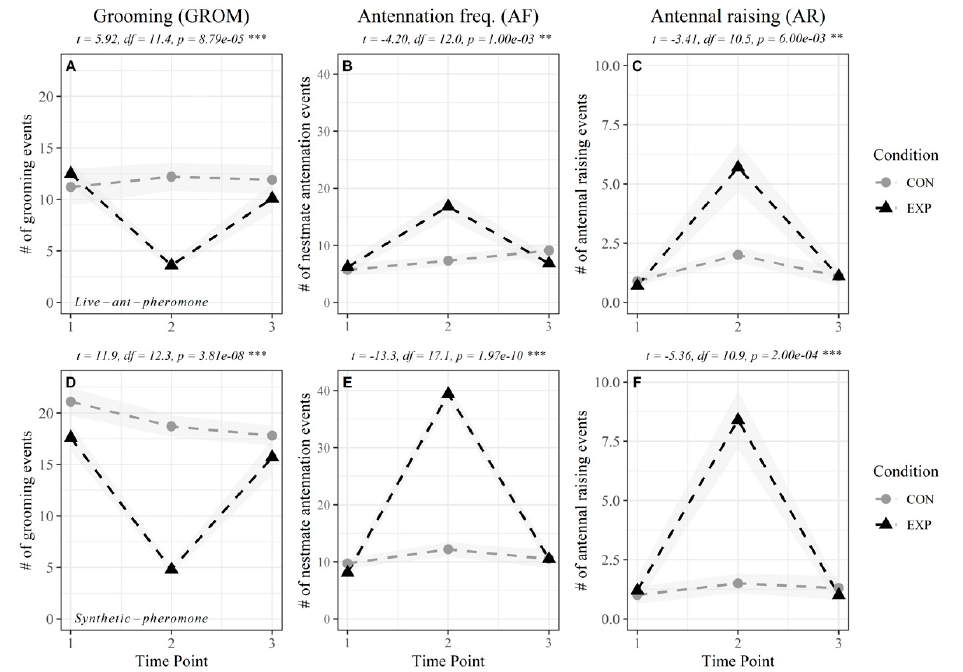
Figure 3. Response to single exposure. Behavioral responses to alarm pheromone emitted from